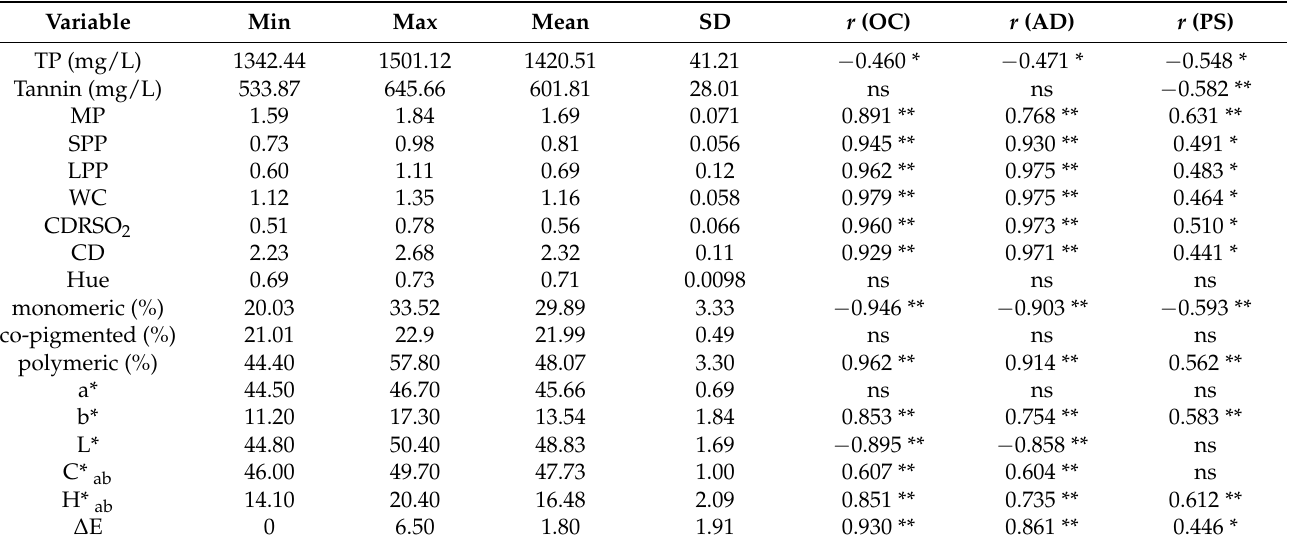
Table 3. Descriptive statistics and Pearson correlation coefficient r versus oxygen consumption (OC), acetaldehyde (AD) or phase (PS) of the variables